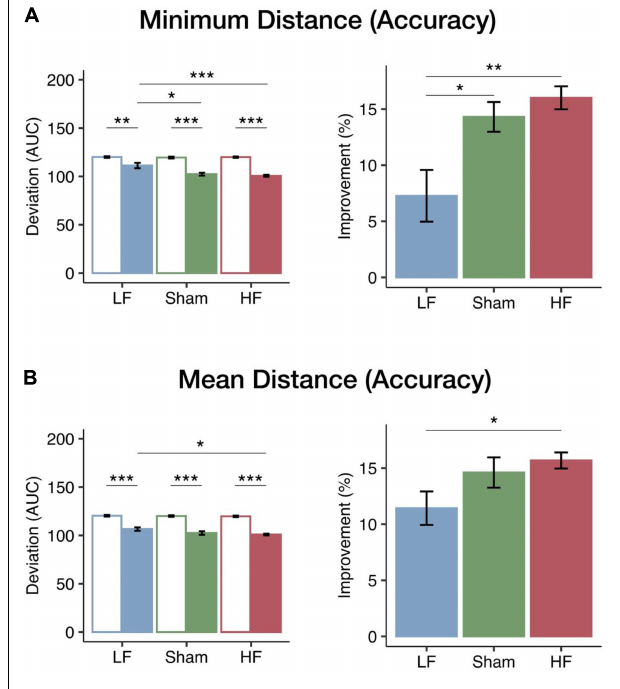
FIGURE 2 | Changes in visuomotor accuracy in the minimum and mean distances from target among the three rTMS groups. The bars (blue, LF, N = 15; green, sham, N = 12; red, HF, N = 16) represent the mean AUC of deviation (left panel) in the pre-test (empty bar) and post-test (solid bar) and mean improvements (right panel). (A) The performance and improvements in the minimum distance from target. All groups had significant decreases in the minimum distance after intervention. Furthermore, in the post-test, both the HF and the sham groups had a significantly smaller deviation than the LF group. The improvements of the HF and sham groups were significantly greater than those of the LF group. (B) Performance and improvements in the mean distance from target. All groups had significant decreases in mean distance after intervention; moreover, the HF group had not only a significantly smaller deviation but also a greater improvement than the LF group. Error bars indicate the standard error of the mean. Bonferroni correction was applied to all p -values (* p < 0.05; ** p < 0.01; *** p <